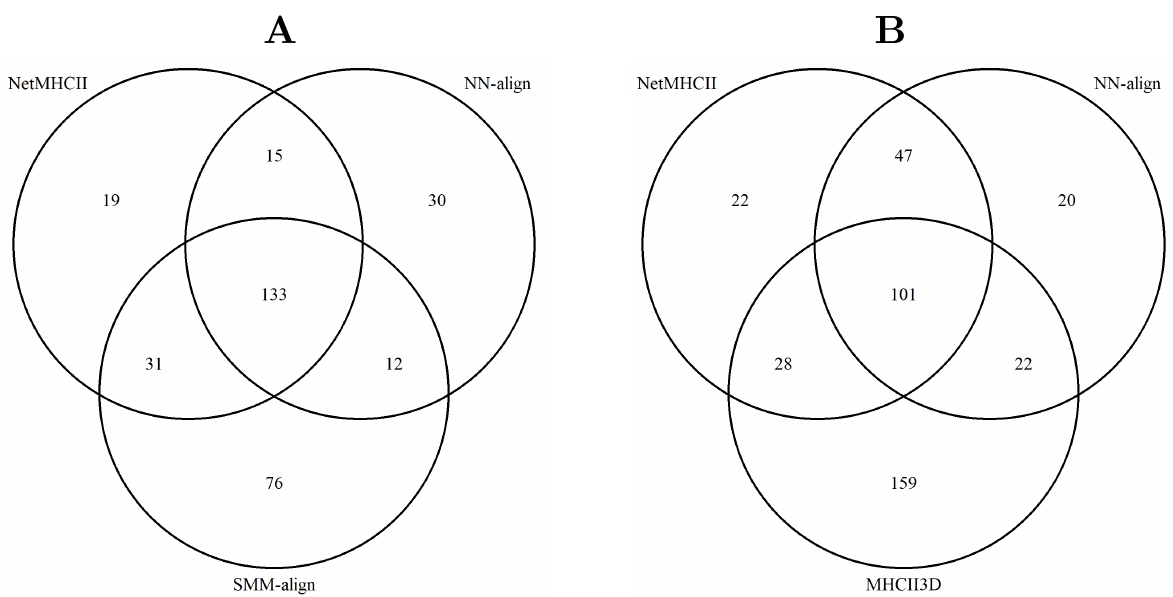
Figure 3. Outlier analysis based on a set of 1078 entries provided on the IEDB database. ( A ) Outliers among the top three performing prediction methods. ( B ) Outliers among the top two performing methods and